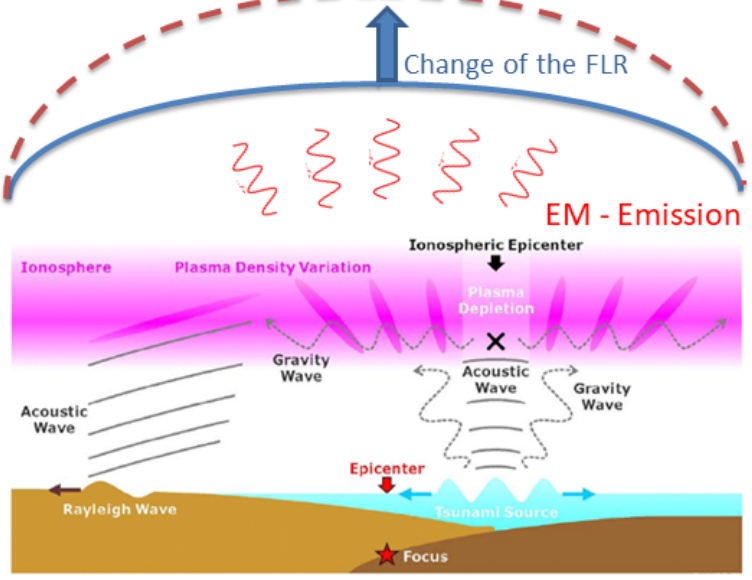
Figure 10. Cartoon describing the basic components of the proposed M.I.L.C.